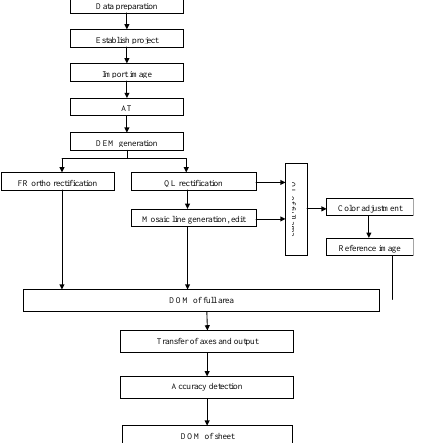
Figure 2. working flow of PixelFactory(for aerial photo)